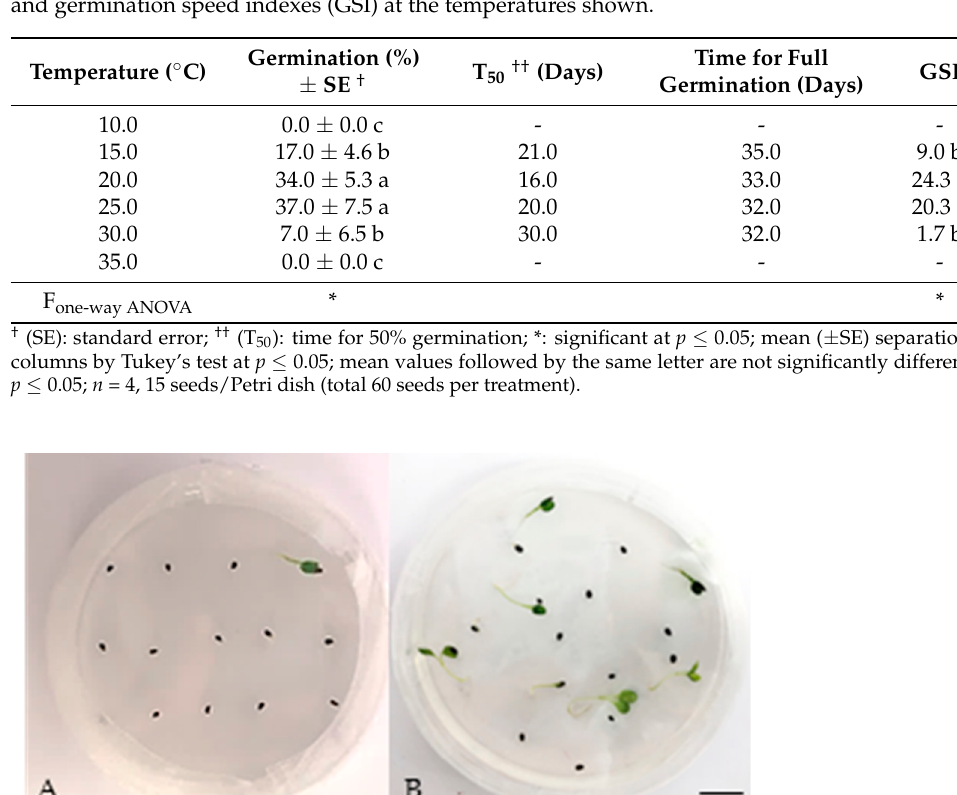
Figure 3. Germination time course curves of Sideritis raeseri subsp. attica seeds affected by temperature. Four Petri dishes (15 seeds/ treatment) were used. 3.2. Micropropagation 3.2.1. Establishment of Initial Cultures S. raeseri subsp. attica plantlets deriving from in vitro-grown seedlings were transferred to a hormone-free medium for further growth (initial culture). Forty days after the transfer, the plantlets had risen to 2.0–2.5 cm in height and showed vigorous growth of 5.0–7.0 leaves (Figure 4A,B). The establishment of initial cultures on MS media that was either hormone-free or supplemented with 0.5 mg L − 1 was successful during a subsequent stage. The shooting percentage was exceptionally high and stood at over 84.0% (Table 2). Two shoots of similar heights were formed (1.1–1.4 cm) on the hormone-free media and the media supplemented with BA and presented no differences. On the other hand, on the media containing PVP, the shoots were the shortest, growing no higher than 0.6 cm (Figure 5A). A small number of short lateral shoots were formed. As to the plantlets themselves, 12.5-13.0% of them grew roots on the MS media that was hormone-free and the MS media that was supplemented with BA (Table 2, Figure 5A).